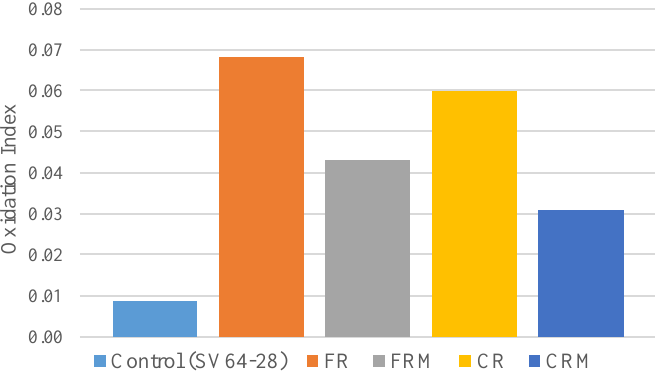
Figure 8. Compilation of FTIR spectra featuring C=O and S=O oxidation bands.